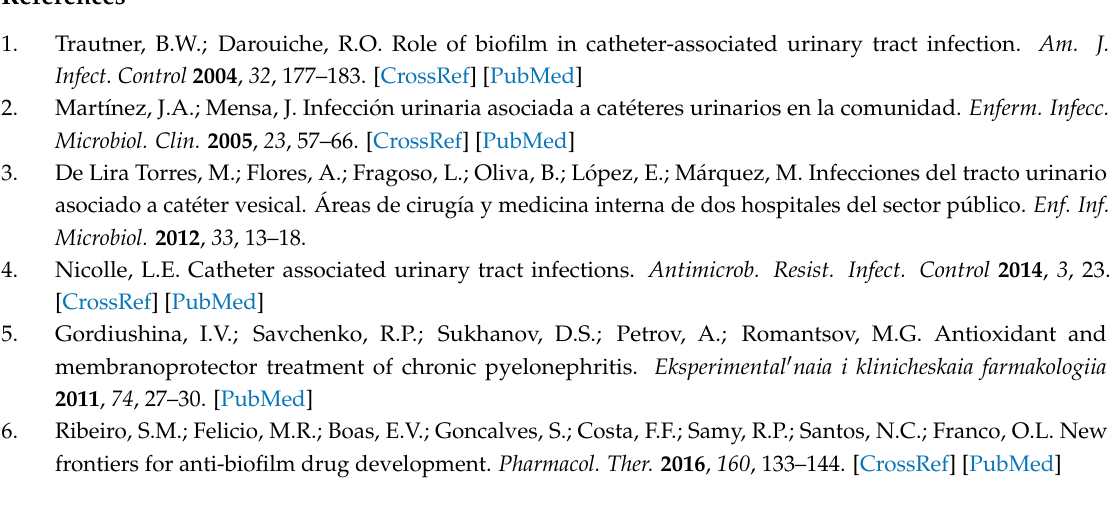
Supplementary Materials: The following are available online. Figure S1: Uropathogenic Escherichia coli growth curve at 37 ◦ C inoculated in LB